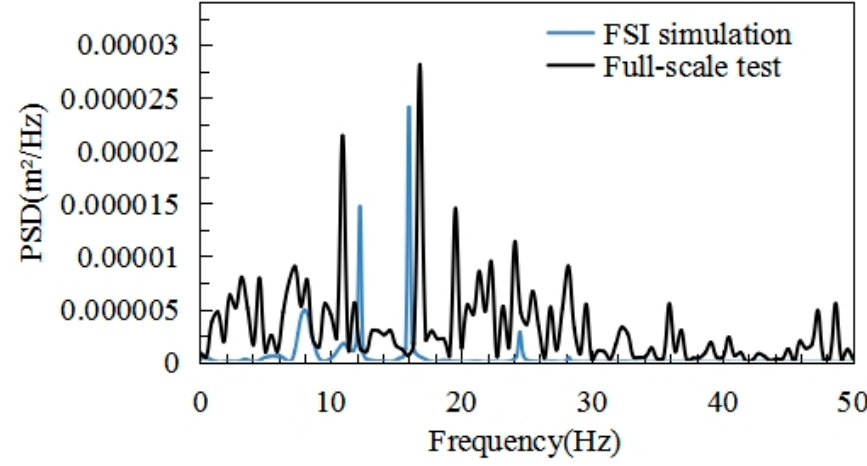
Figure 6. PSD of the vibration signal of the windshield.